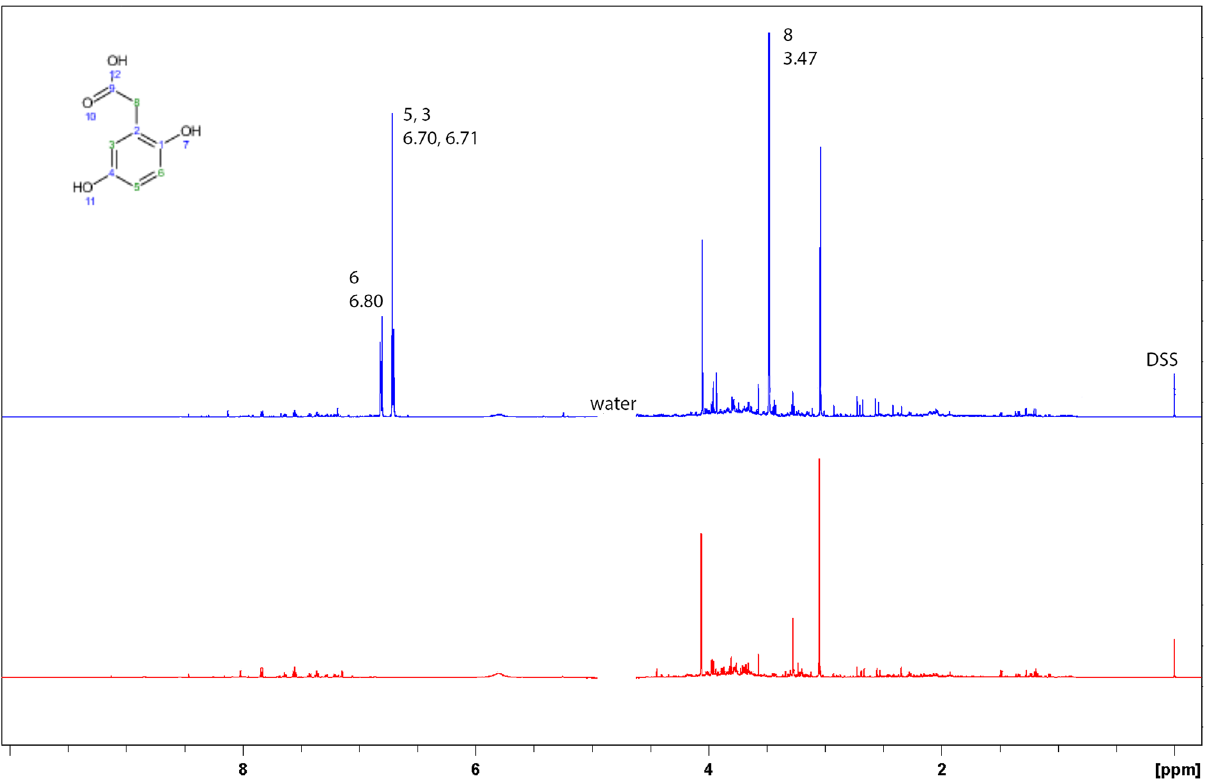
Figure 1. Comparison of 1 H NMR spectra of a urine sample (top) from AKU patient (U425, HGA concentration 33.0 mM) with a urine sample (bottom) from a control (C391, no